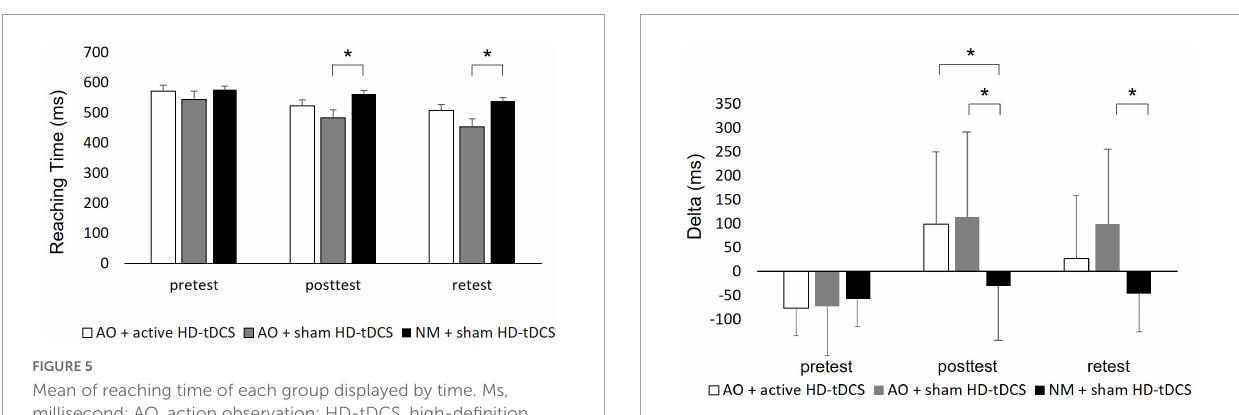
FIGURE6 Mean of delta of each group displayed by time. ms, milliseconds; AO, action observation; HD-tDCS, high-definition transcranial direct stimulation. Error bars show the standard deviation. Asterisks denote a significant